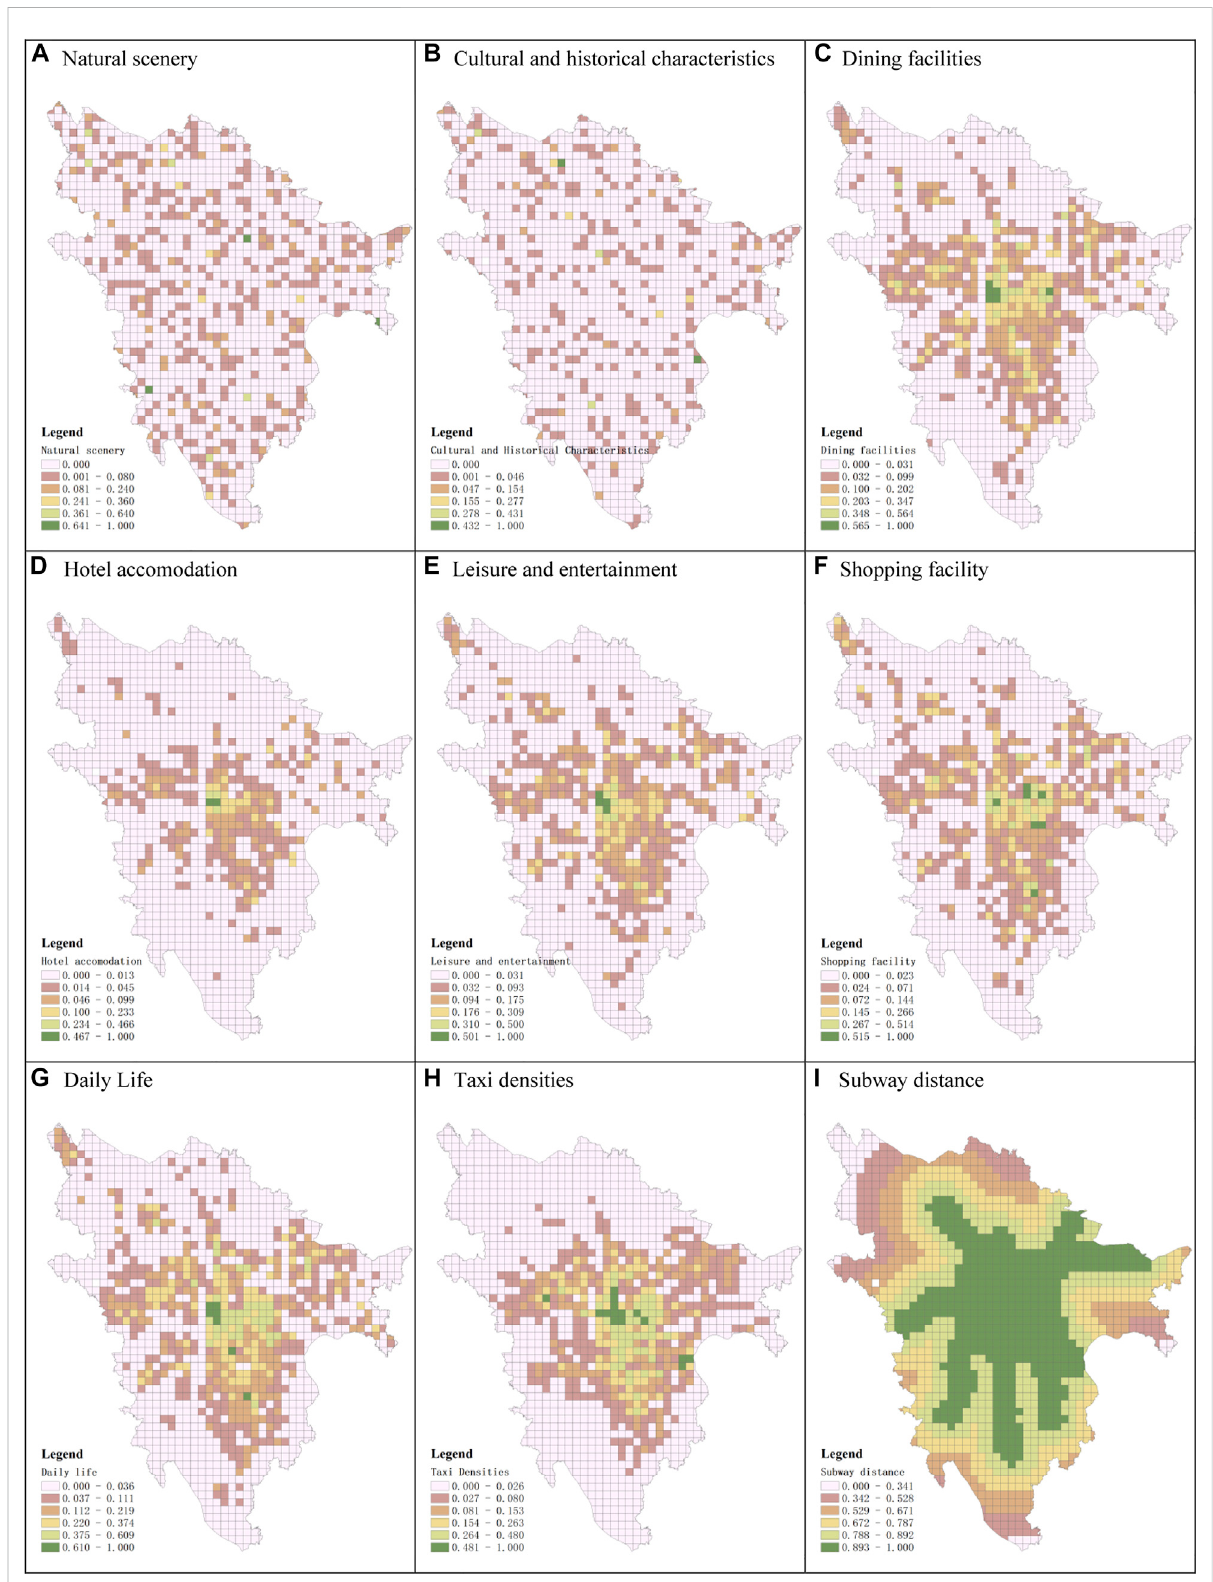
FIGURE 3 Spatial distribution of independent variables. (A) Natural scenery. (B) Cultural and historical characteristics. (C) Dining facilities. (D) Hotel accommodation. (E) Leisure and entertainment. (F) Shopping facility. (G) Daily life. (H) Taxi densities. (I) Subway